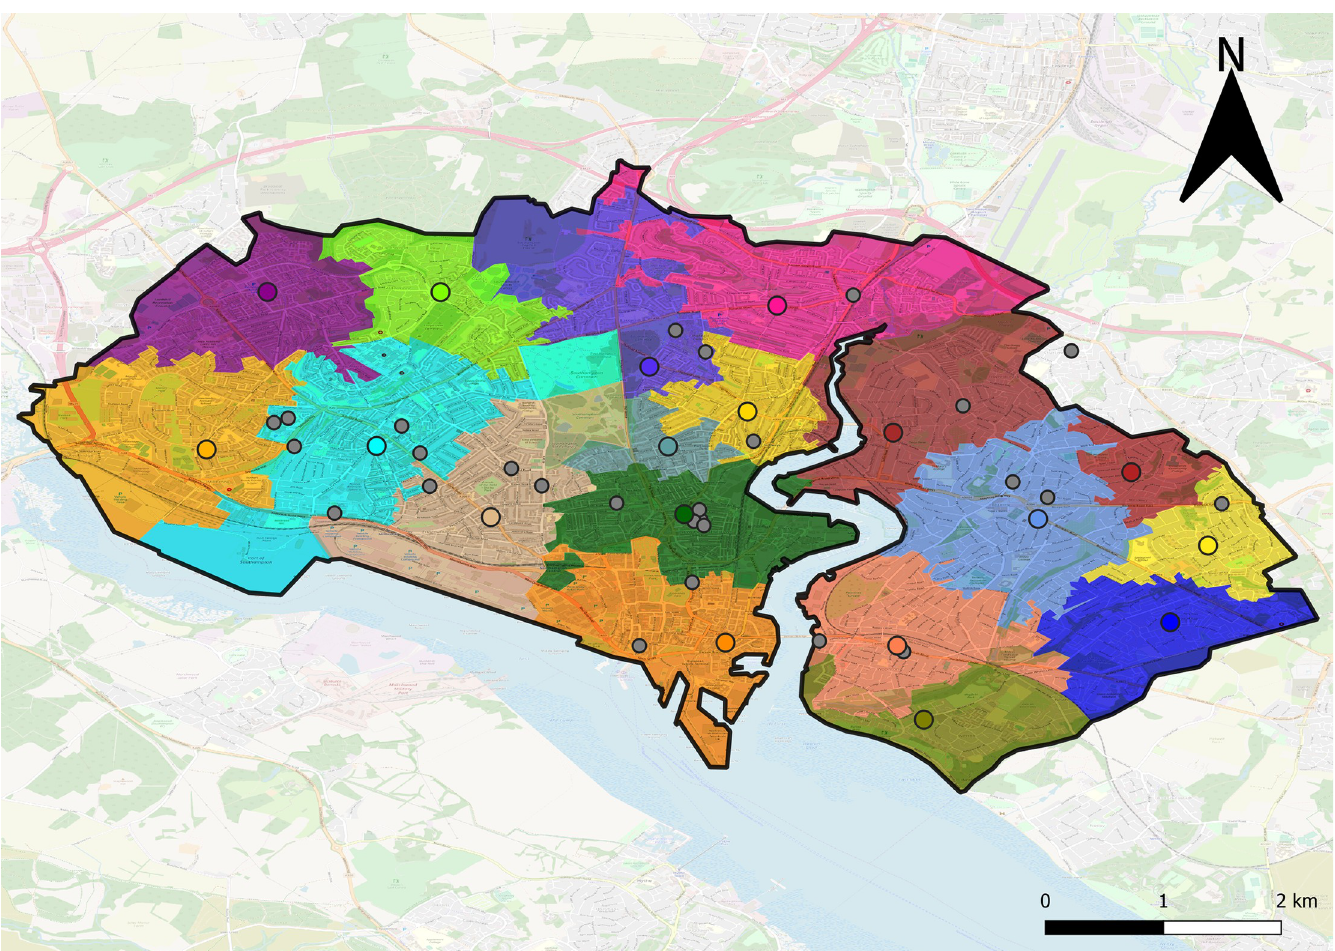
Fig 4. Assignment of patients to GP surgeries for the city of Southampton. Considering a high testing demand estimation and T = 2000. Each circle represents a GP surgery, same colour indicates assignments. Smaller grey circles indicate that no machine was allocated to that GP surgery. This assignment requires 18 machines in total. Map data copyrighted OpenStreetMap contributors and available from